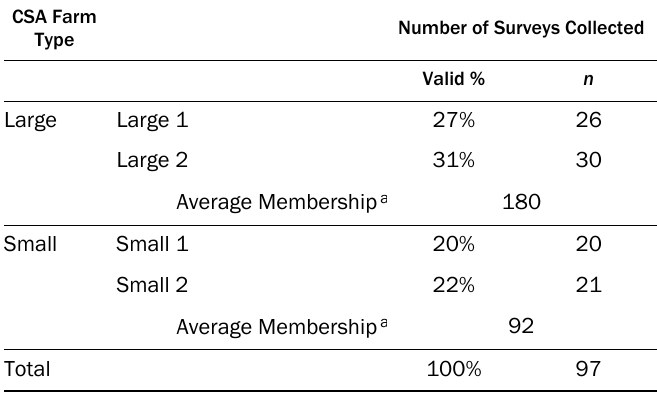
Table 1. Farm Sample